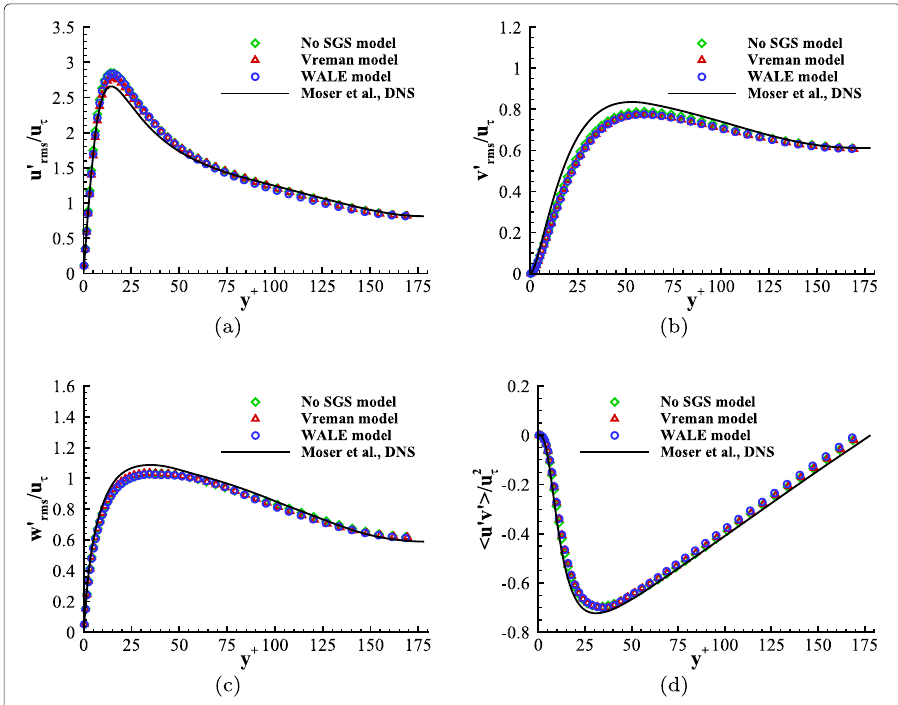
Fig. 4 The r.m.s. velocity fluctuations and Reynolds stress for the fully developed turbulent channel flow. a the r.m.s. streamwise velocity fluctuation; b the r.m.s. wall-normal velocity fluctuation; c the r.m.s. spanwise velocity fluctuation; d Reynolds